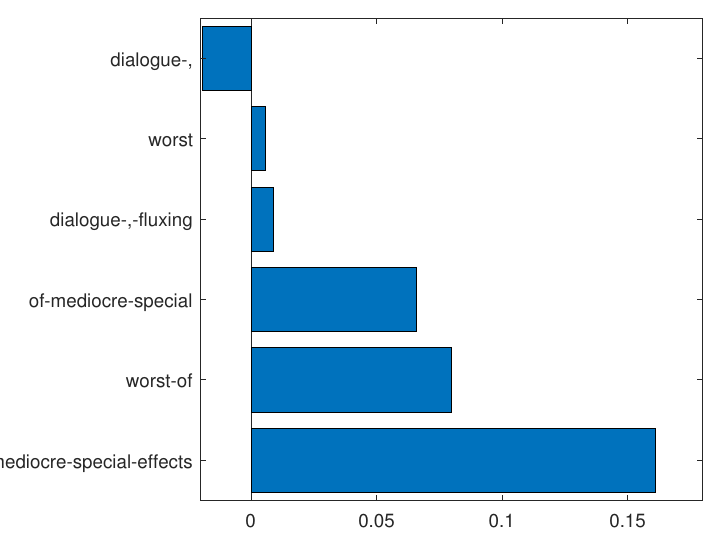
Figure 8. N-grams determined from R 26 and the following “tweet”: “a zippy 96 min of mediocre special effects, hoary dialogue, fluxing accents, and—worst of all—silly-looking morlocks”. The sum of the n-grams linear contributions is 0.302.